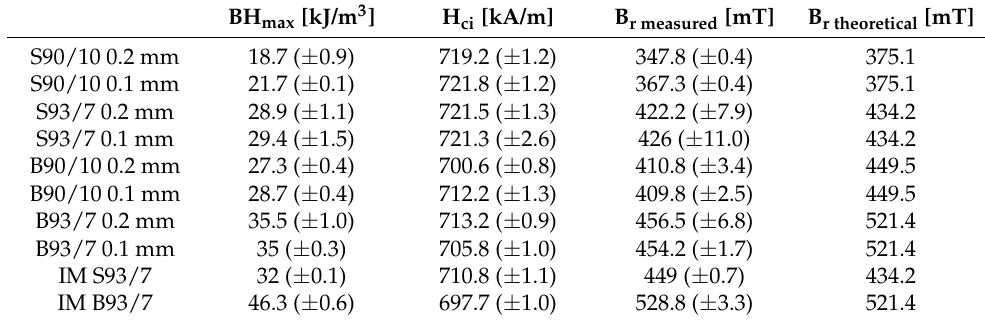
Table 9. Measured magnetic properties of FDM-printed and injection-moulded (IM) samples.